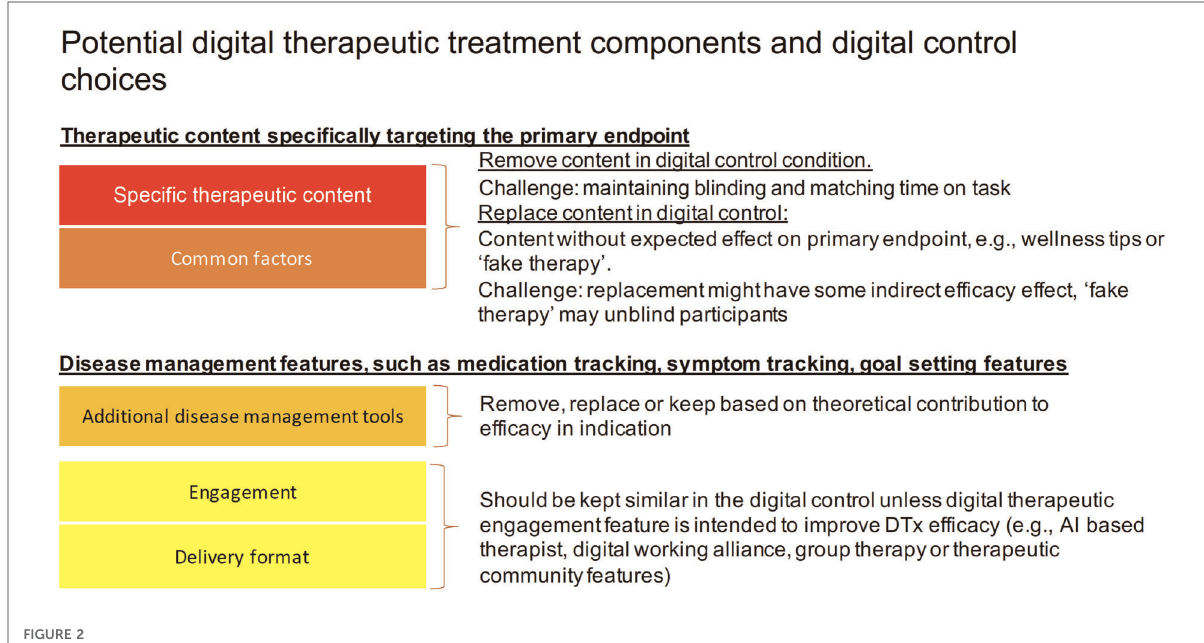
FIGURE 2 Potential choices in designing a digital control condition for